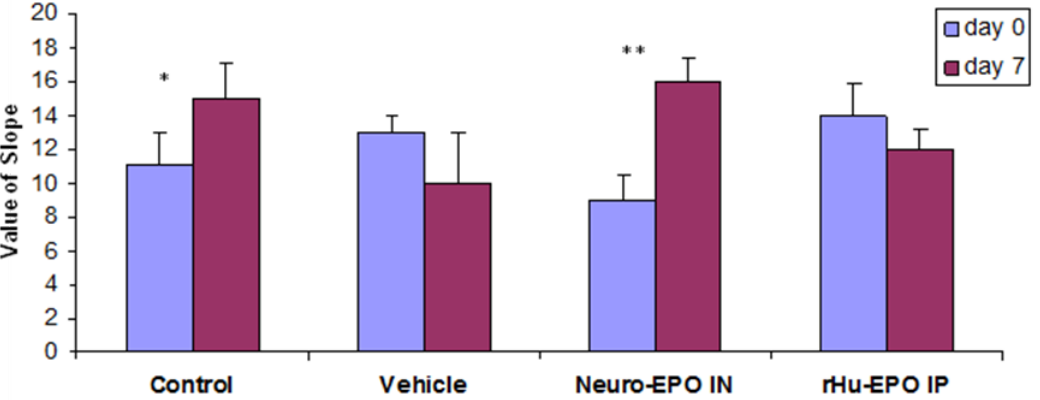
FIGURE 3. Slope values before and 7 days after the permanent occlusion of the right common carotid in the Mongolian gerbil. Asterisk indicates a significant difference between 0 and 7 days after lesion (* p < 0.05; ** p < 0.01) (n = 35 for